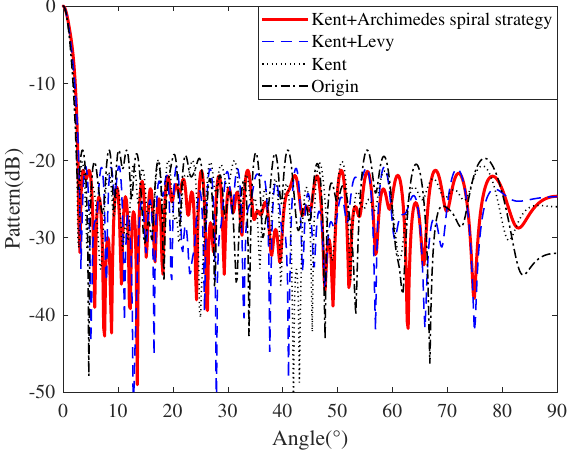
Figure 7. Beampatterns under three search path planning